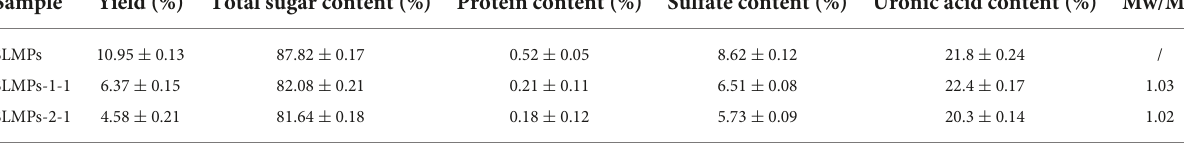
TABLE 2 Chemical composition and relative molecular weight analysis of SLMPs-1-1 and SLMPs-2-1 ( x ± s, n = 3).